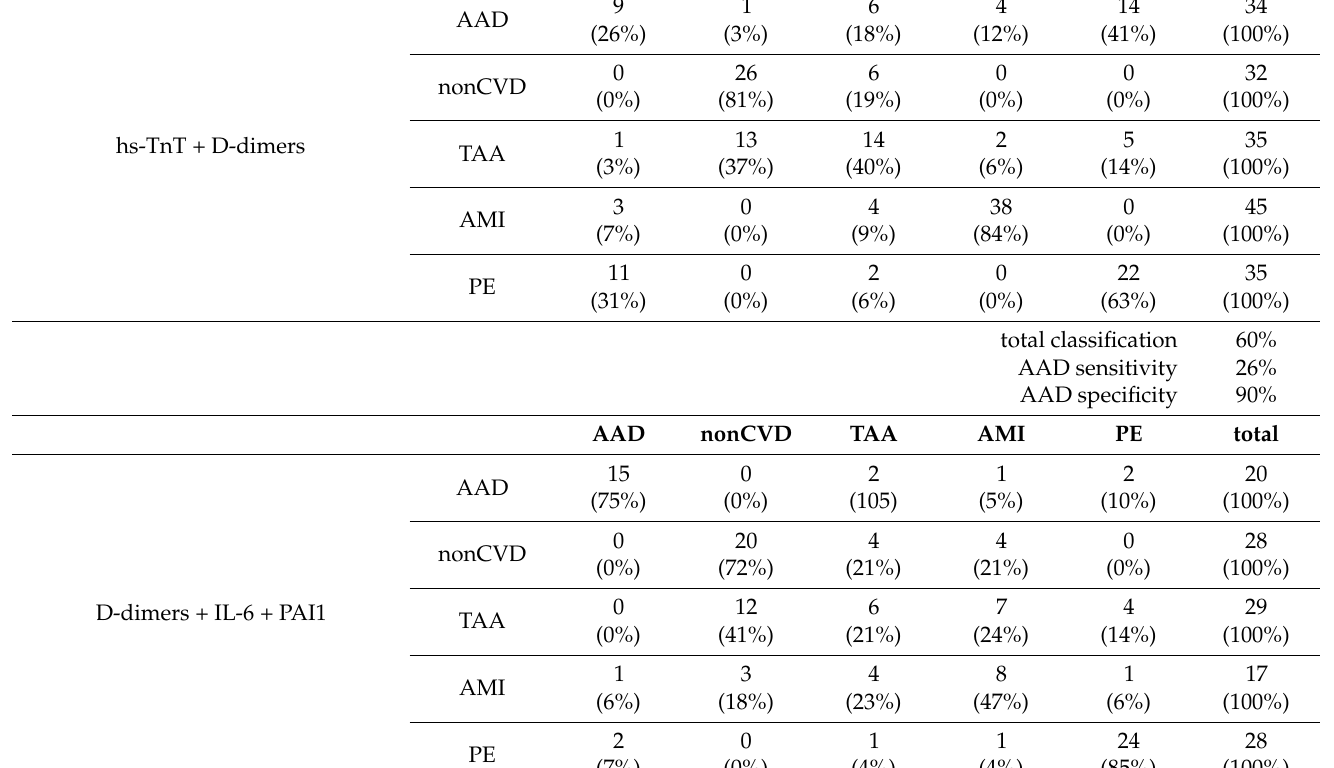
Table 5. Models of discriminant analysis in AAD classification in the confirmatory cohort.